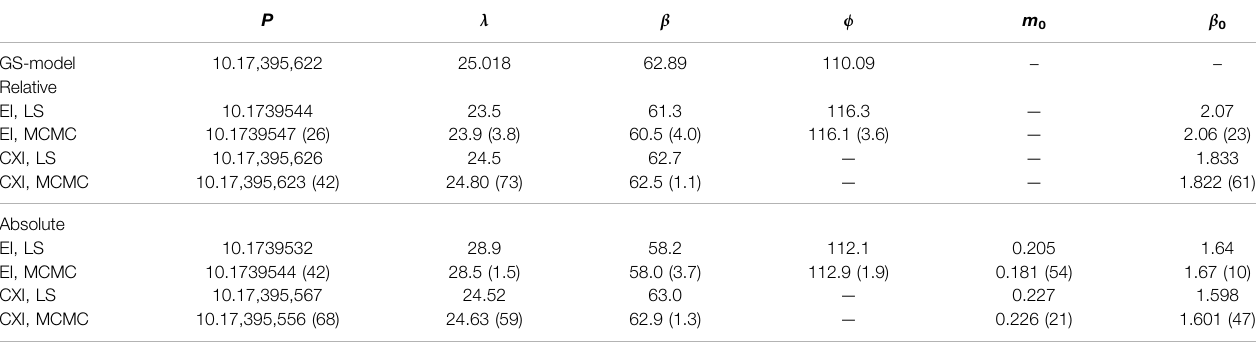
TABLE 8 | Rotation period P (h), pole longitude λ ( ° ) and latitude β ( ° ), rotational phase ϕ ( ° ), and phase-curve parameters m 0 (mag) and β 0 (mag/rad) for the simulated Gaussian-sphere asteroid. The parameter values on the topmost line (GS-model) represent those utilized to simulate the observations. For the simulation of the scattering model, see text. On the lines thatfollow, the parameter values represent least-squares solutions (LS) and means from MCMC sampling (MCMC) asobtained from ellipsoidinversion(EI)andconvexinversion(CXI)inthecasesofrelative(Relative)andabsolutesimulatedobservations(Absolute).FortheMCMCsolutions,theparameter1- σ standard deviations are given in the units of the last digit shown.